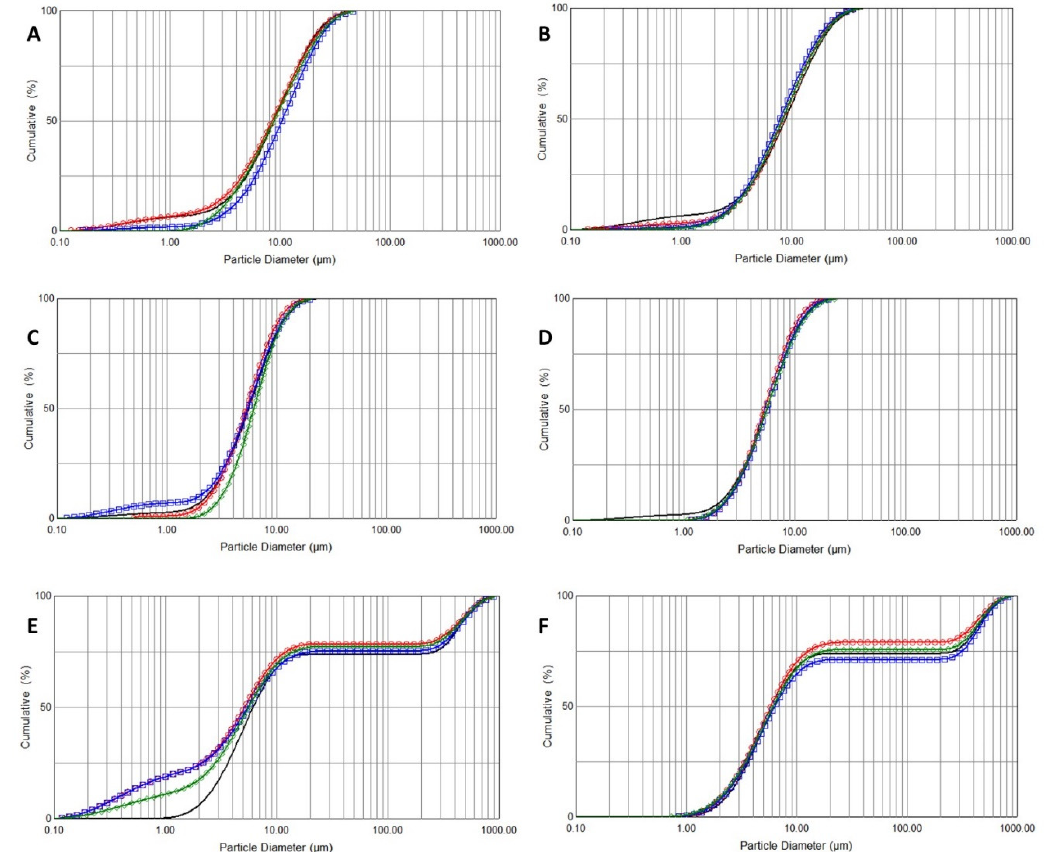
Figure 3. Cumulative particle size distribution (PSD) of aerosolized products by laser diffraction evaluation, the overlay of three sample repetitions (red, blue and green lines) and NaCl 0.9% saline solution, used as reference (black line). ( A , B ) J2 jet nebulization of PLG-OMP and iPLG-OMP, respectively; ( C , D ) J3 jet nebulization of PLG-OMP and iPLG-OMP, respectively; ( E , F ) US ultrasonic nebulization of PLG-OMP and iPLG-OMP, respectively.